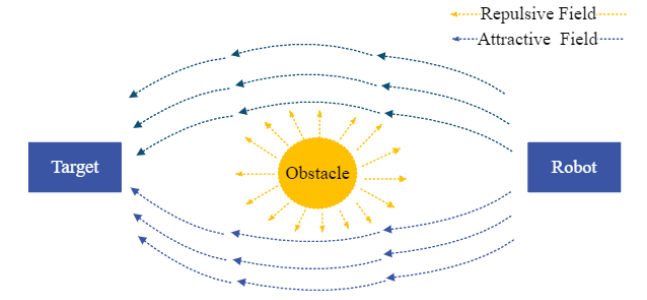
Figure 2. Illustration of the APF